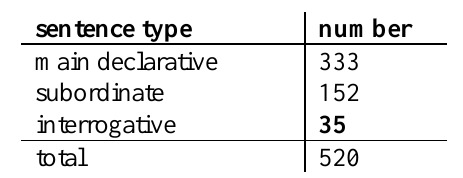
Table 1 . Number of analyzed sentences containing decir ‘say’ plus an overt